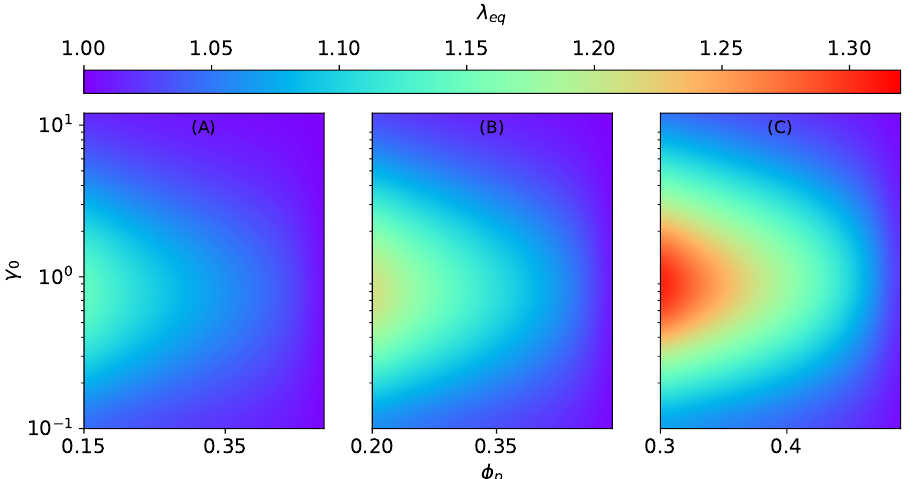
Figure 5. The magneto-induced elongation λ eq for MAEs with SD microstructure as a function of the initial aspect ratio γ 0 and the volume fraction φ p at constant | (cid:126) H 0 | = 470 kA/m, G m = 17 kPa. ( A ) φ = 0.15, ( B ) φ = 0.2, ( C ) φ =